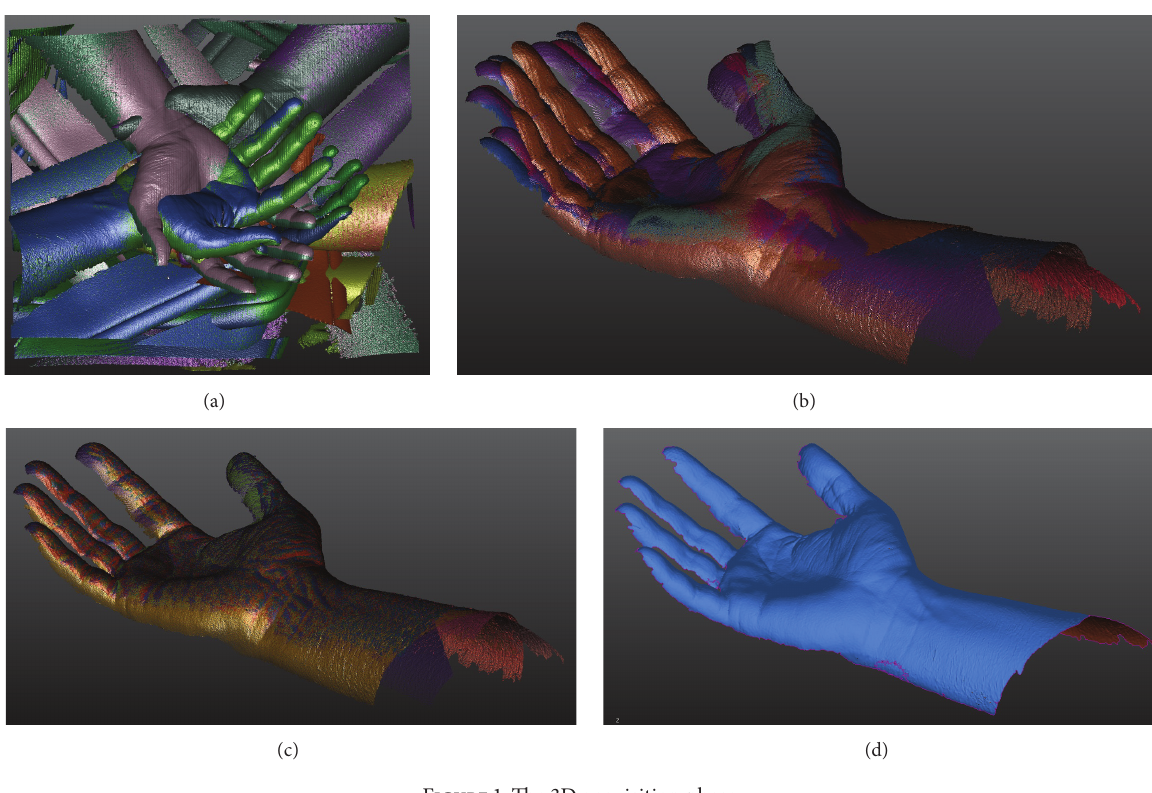
Figure 1: The 3D acquisition